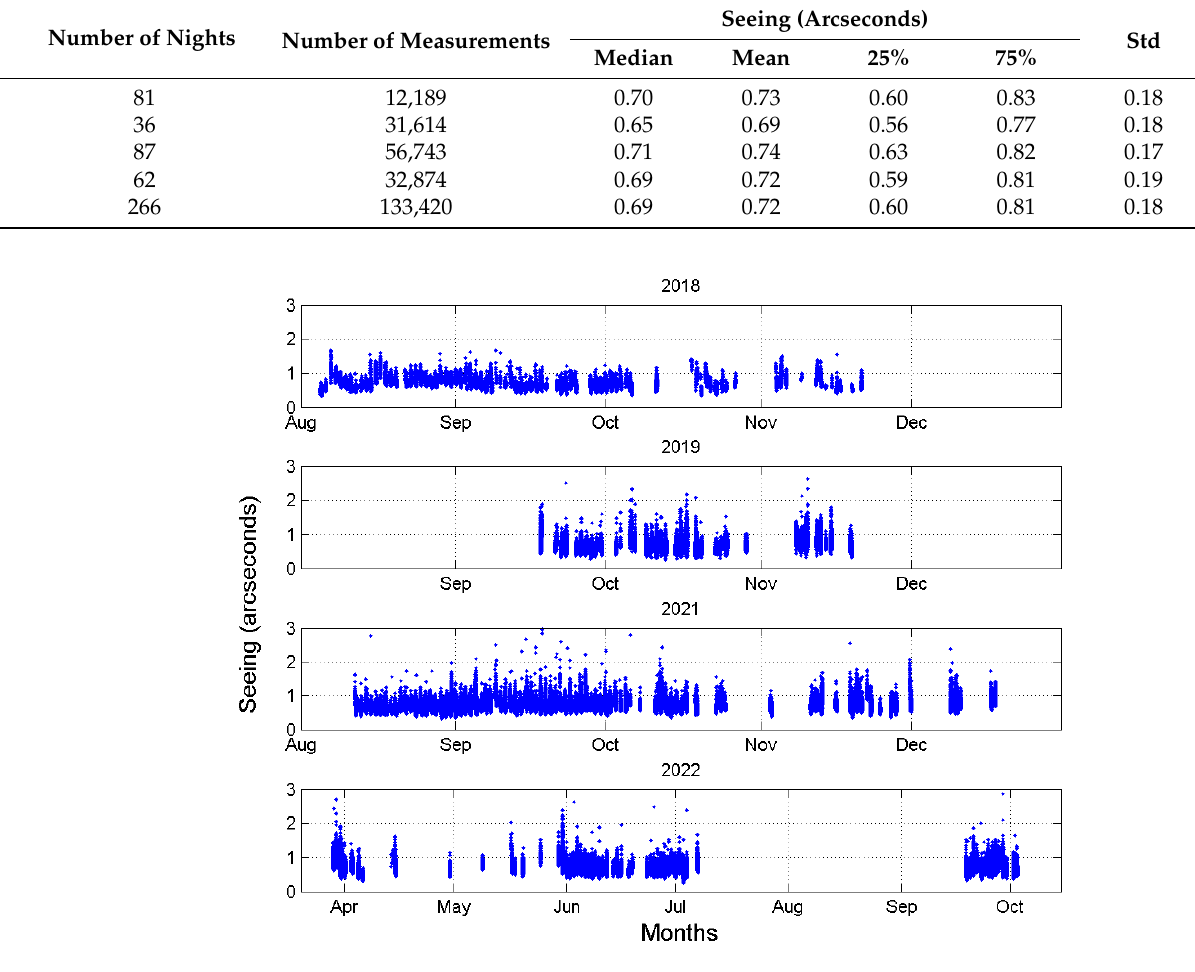
Figure 4. The seeing time series at Maidanak observatory for